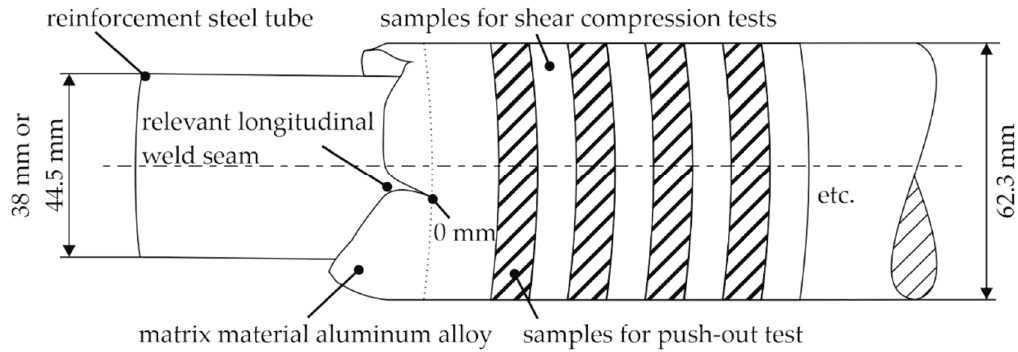
Figure 3. Schematic illustration of a compound profile with alternating sampling for push-out tests and shear compression tests with planned geometry of the compound profile.